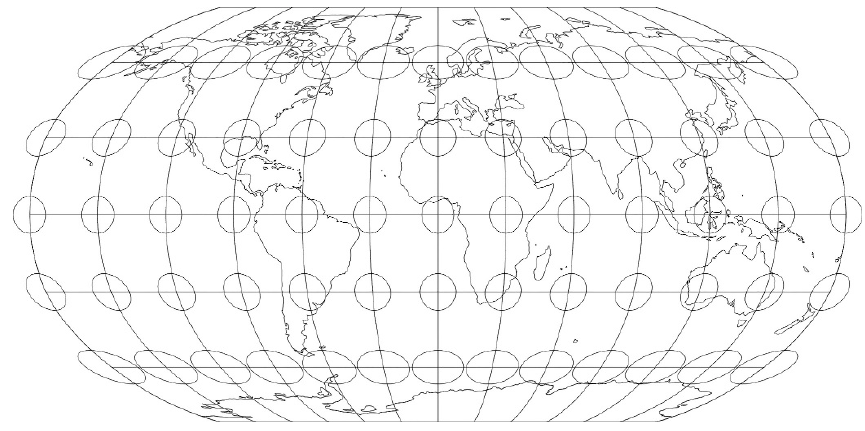
Figure 3. Robinson map projection with as overlay the Tissot indicatrix.